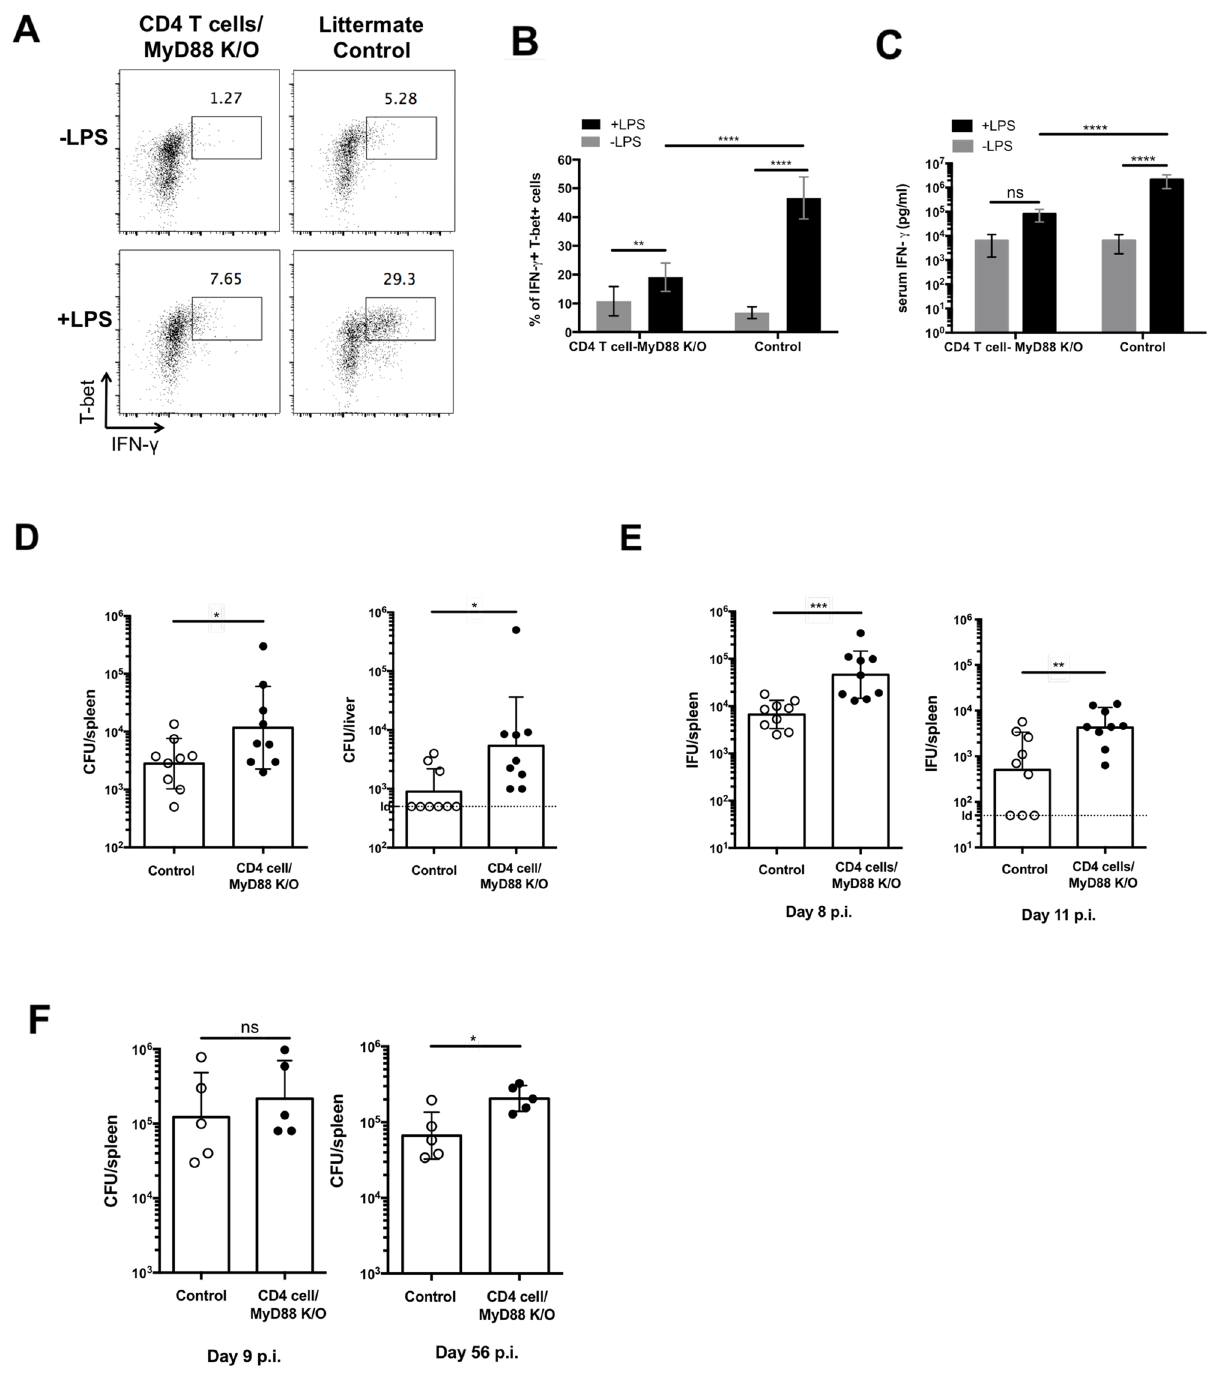
Fig 8. Mice lacking Myd88 in CD4 T cells are susceptible to multiple infections. CD4-Cre Myd88 fl/fl mice and littermate control were infected with 5 × 10 5 Salmonella Typhimurium. Two weeks later, infected mice were injectedi.v. with 10ug LPS. (A-C) Spleenswere collected 4 hours later to examineIFN- γ production by Th1 cells by flow cytometry. Representative flow cytometry plots (A) and a graph of combined data (B) are shown. Serum was also collected4 hours after LPS treatment to determine IFN- γ concentration by ELISA (C). (D-F) Bacterial loads in the spleenand/or liver of individualmice were determinedat day 35 post-infection for Salmonella -infected mice (D), day 8 and day 11 for Chlamydia -infected mice (inclusion-forming units, IFC) (E), or day 9 (early stage) and day 56 (late stage) for Brucella -infected mice (F). Data shownwere combinedfrom two experiments containing at three to five mice per group. Statistical analyseswere performed by two-way ANOVA with a Bonferroni posttest. Error bars represent the mean ± SEM. p < 0.0001 ( **** ),0.0002 ( *** ), 0.0021 ( ** ), 0.0332( * ), 0.1234